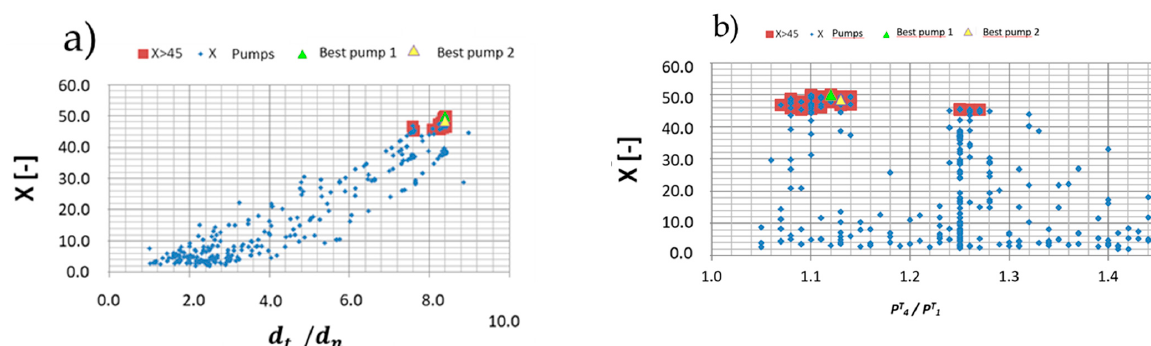
Figure 12. ( a , b ) Objectif function behavior against geometric and operational parameters.